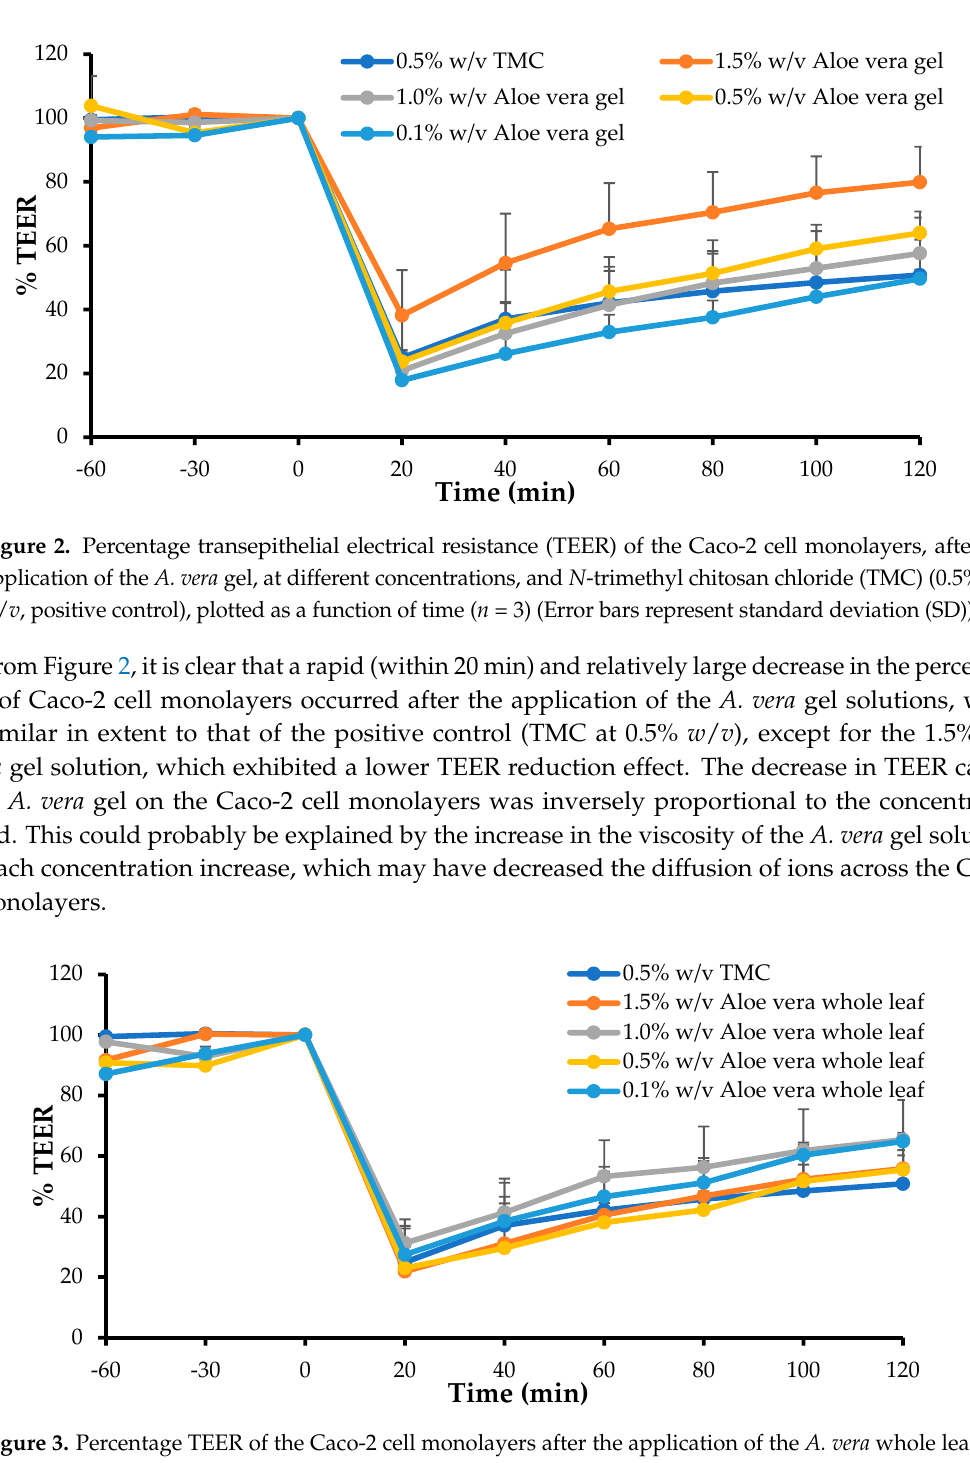
Figure 3. Percentage TEER of the Caco-2 cell monolayers after the application of the A. vera whole leaf, at different concentrations, and TMC (0.5% w / v , positive control) plotted as a function of time ( n = 3) (Error bars represent SD).